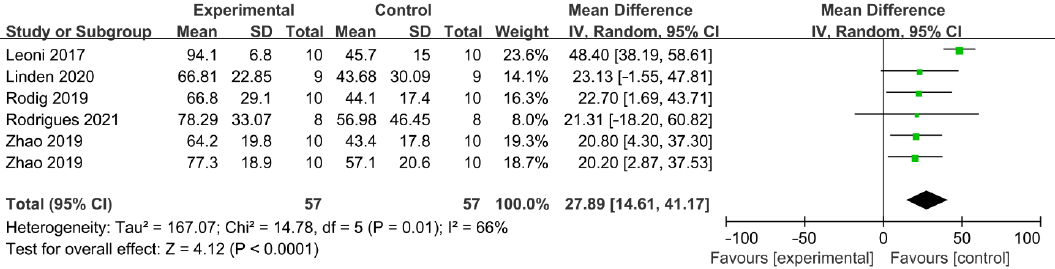
Figure 4. Forest plot and meta ‐ analysis of comparison between PUI and SNI [35–37,39,42].